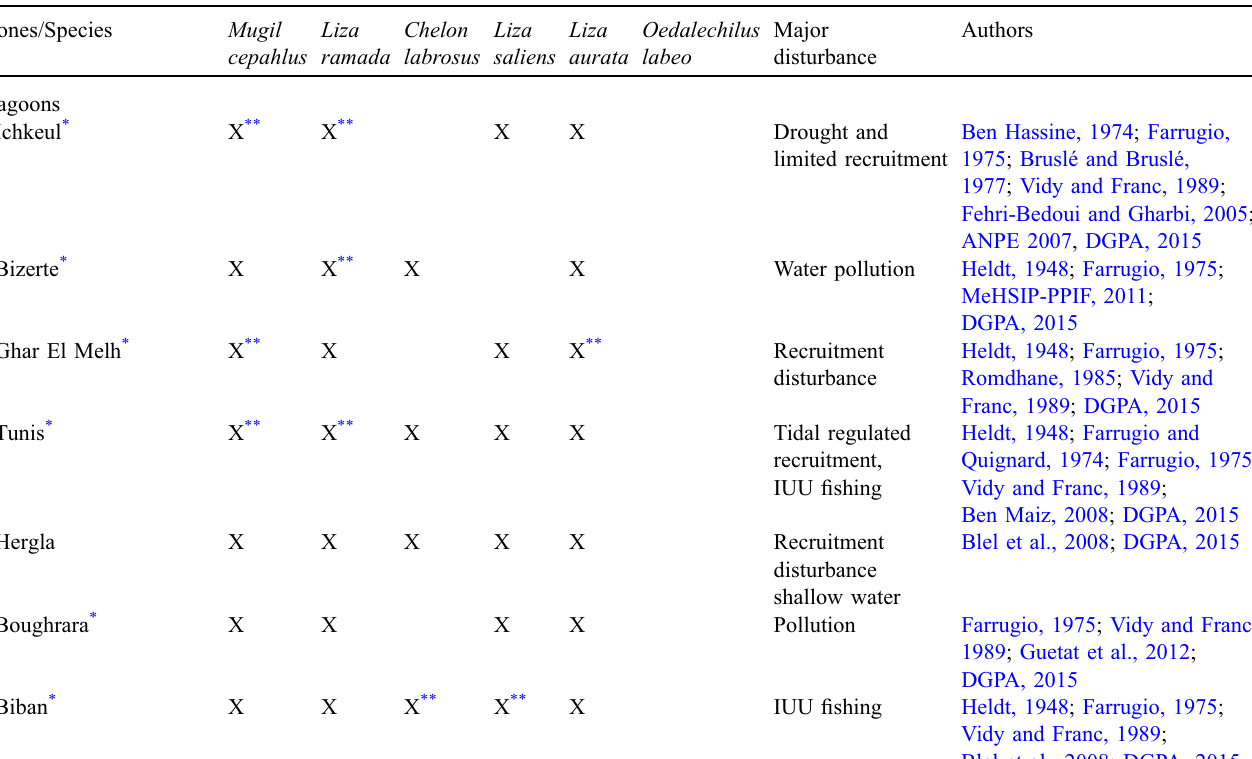
Table 4. Mugilids distribution in Tunisians